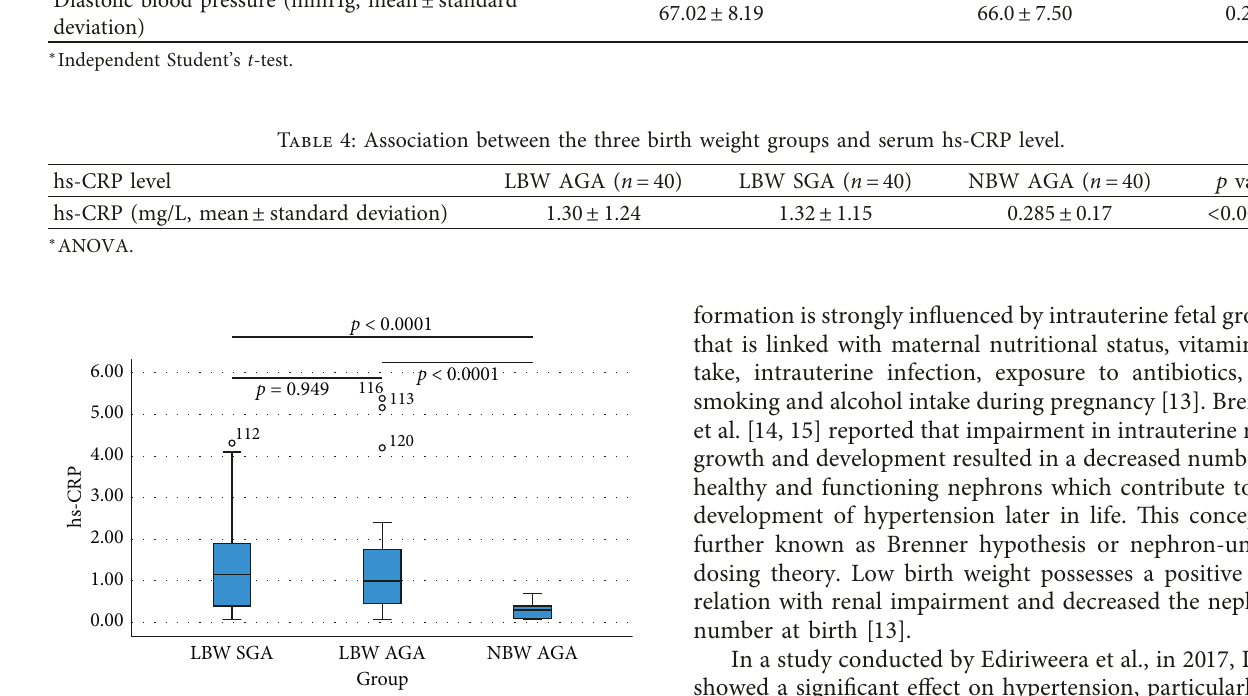
Figure 3: Box plot association between birth weight and hs-CRP level in children with history of LBW SGA, LBW AGA, and NBW